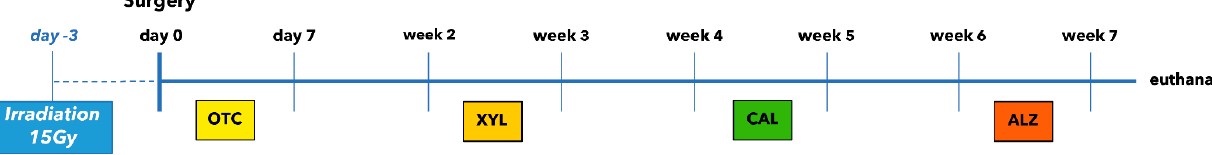
Figure 8. Time schedule of fluorescence labelling. Each marker has been applied three times. All the rabbits were sacrificed after 8 weeks with an overdose of pentobarbital